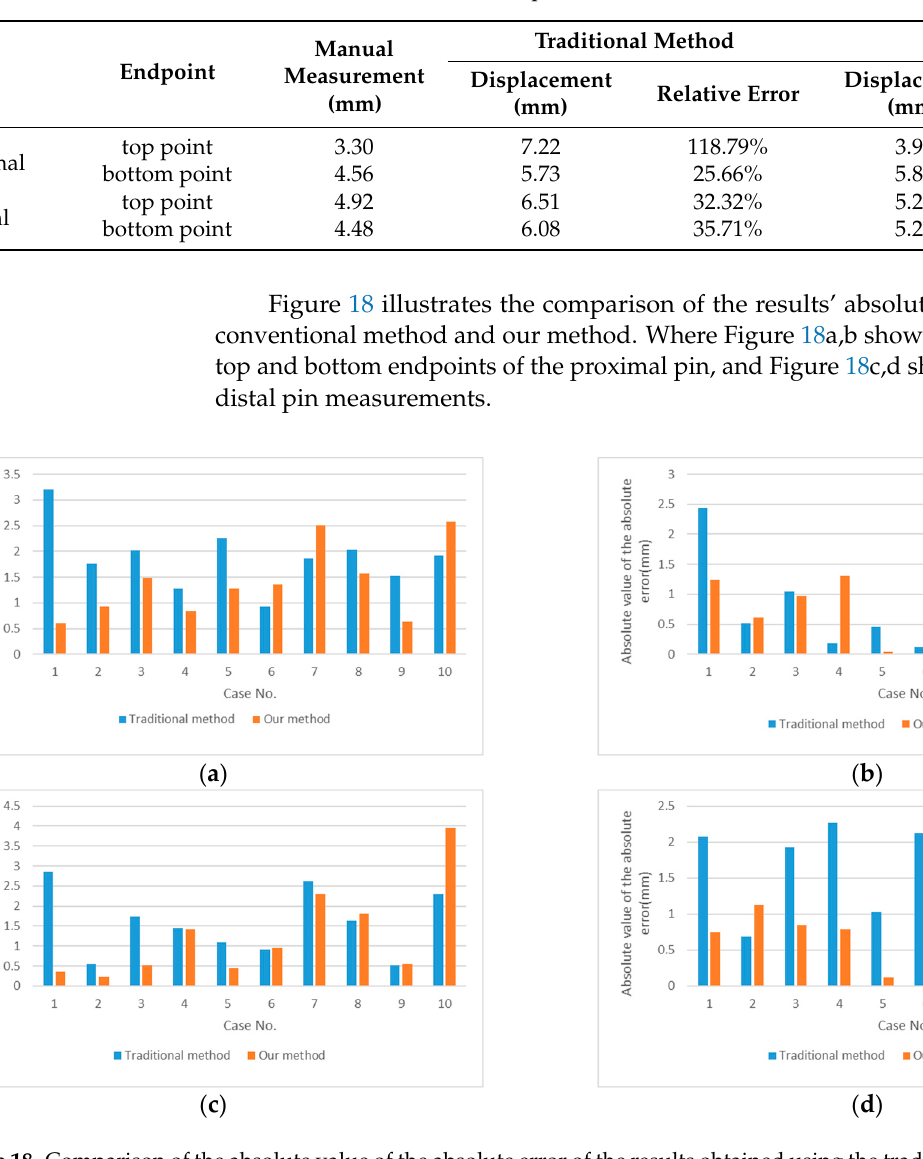
Figure 18. Comparison of the absolute value of the absolute error of the results obtained using the traditional method and the method proposed in this paper: ( a ) Comparison of top endpoint displacement results on the proximal pin. ( b ) Comparison of bottom endpoint displacement results on the proximal pin. ( c ) Comparison of top endpoint displacement results on the distal pin. ( d ) Comparison of bottom endpoint displacement results on the distal pin.